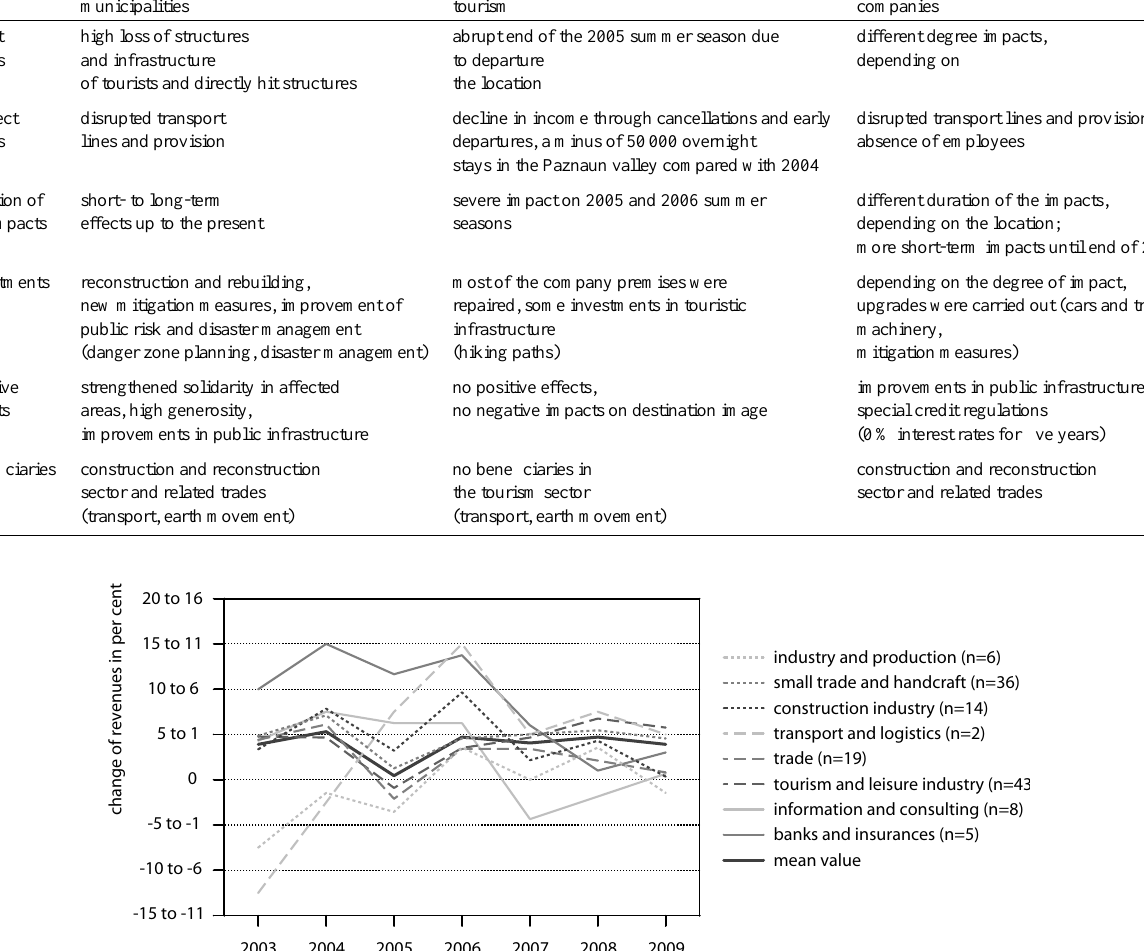
of the 2005 floods affected mainly the overnight stays in the summer